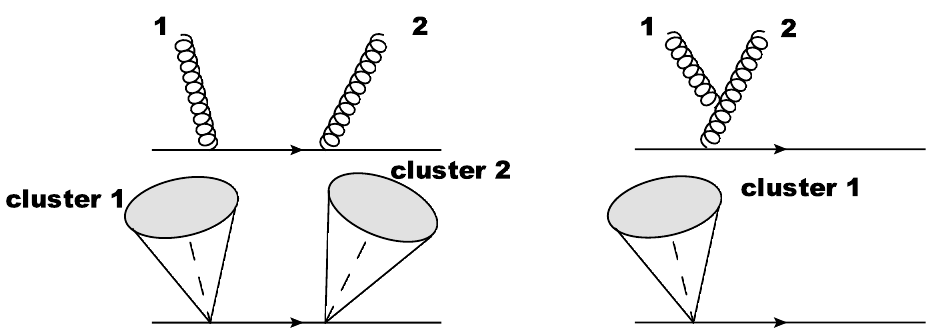
Figure 1 . Example of decomposition into correlated clusters for emissions o(cid:11) a quark line. The left con(cid:12)guration corresponds to the emission of two independent gluons, and it is mapped onto two separate clusters. The right con(cid:12)guration corresponds to the emission of the second gluon o(cid:11) the (cid:12)rst one, and it is mapped onto a single cluster. The correlated clusters are not to be confused with partonic